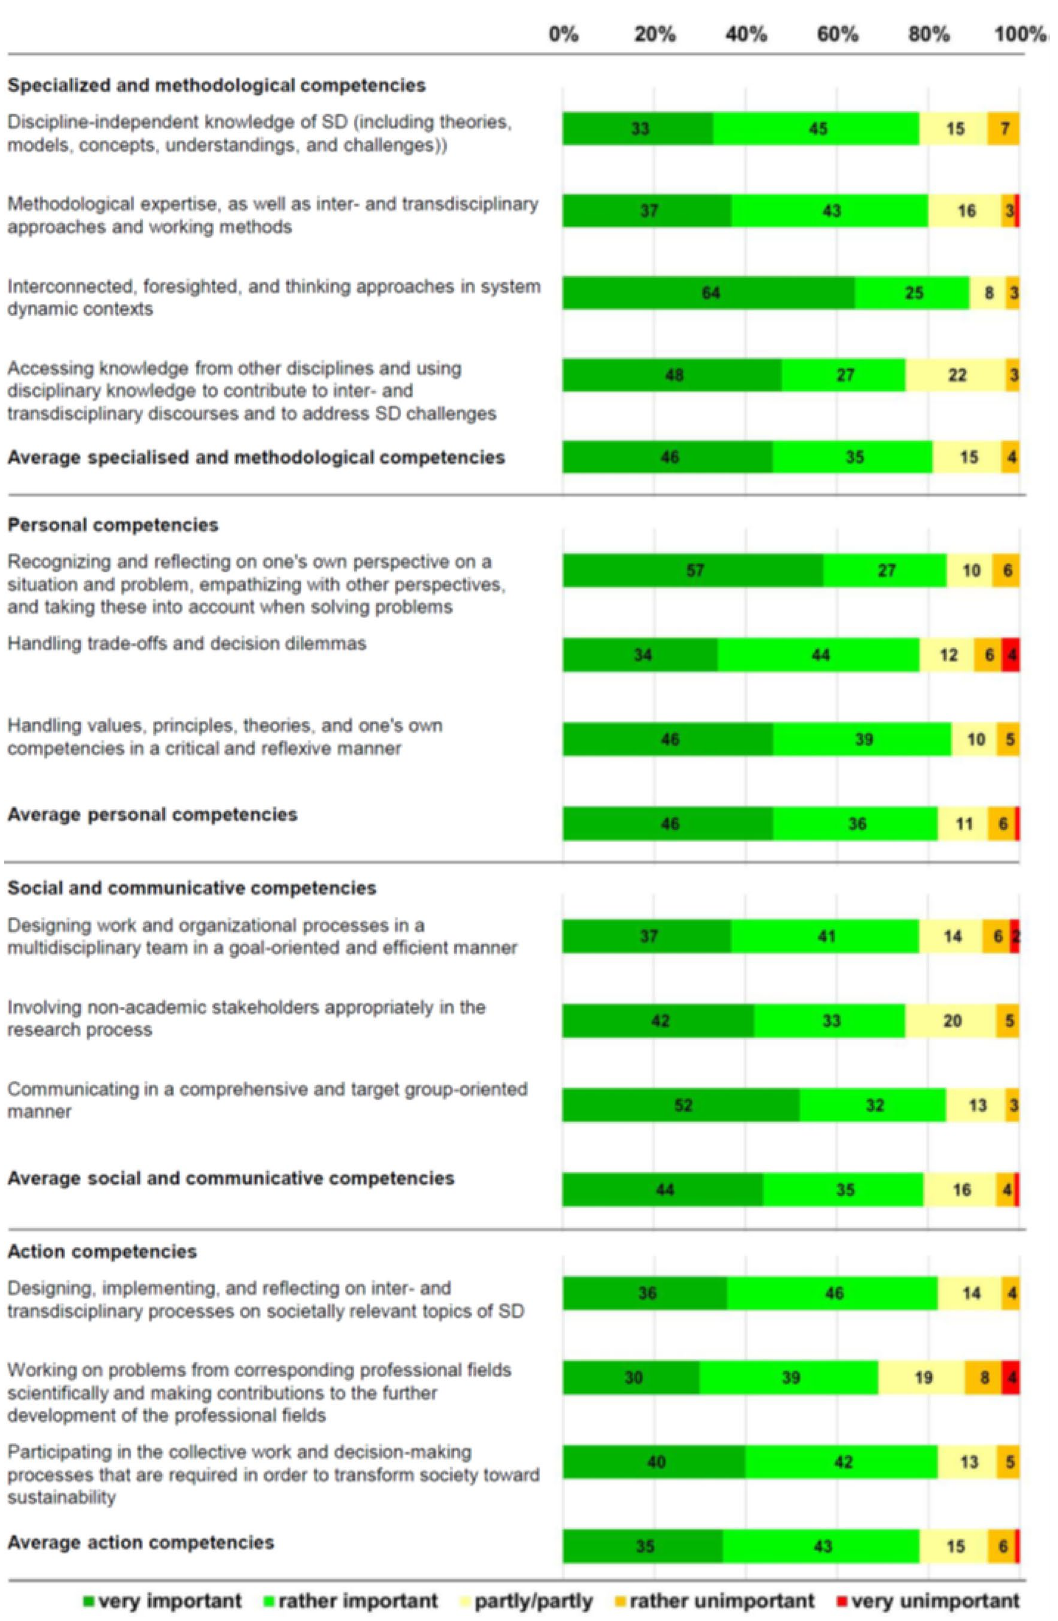
Fig. 5 Average regarding assessment of the importance of fostering each competency and competency category in the study programs (average of the three groups surveyed per competency, as well as the average per competency